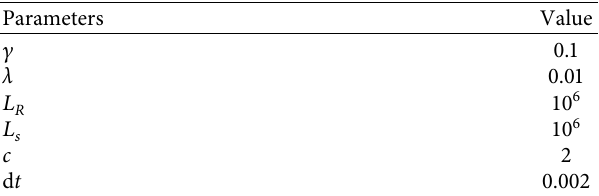
Table 4: Parameters for obtaining K and simulation for τ � 1 s and sinusoidal disturbance.